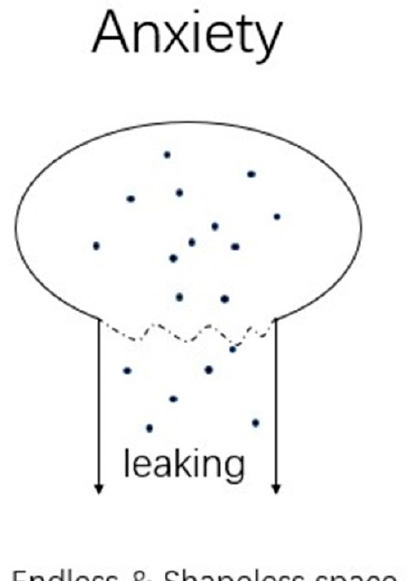
Figure 3. The leaking wholeness.